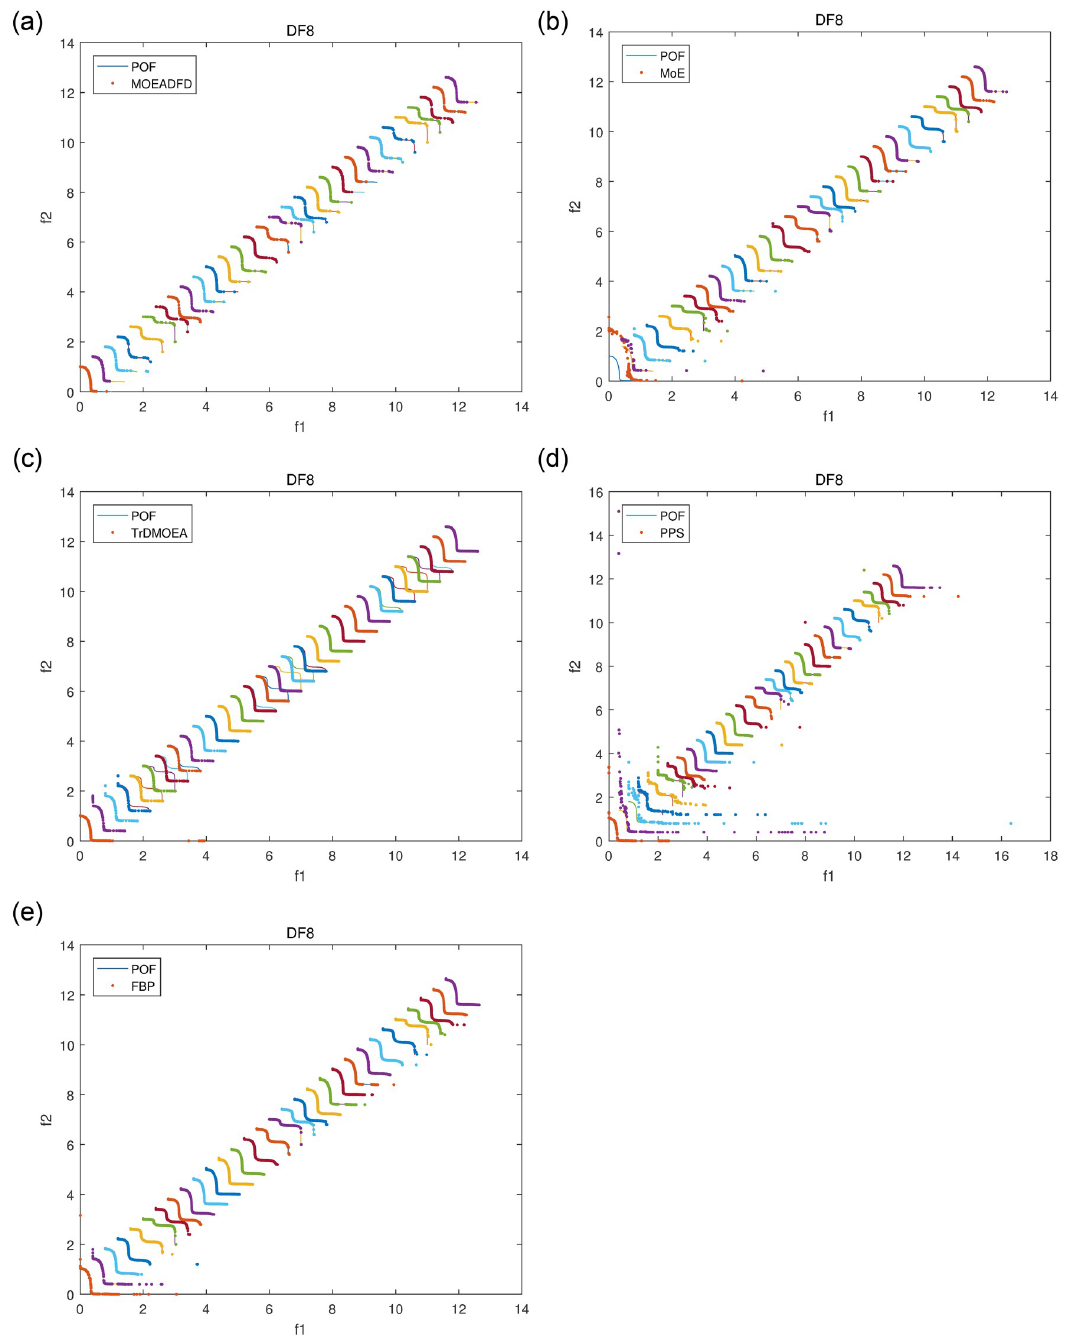
Fig 7. POF approximations of five algorithms for DF8 with n t = 10 and τ t =